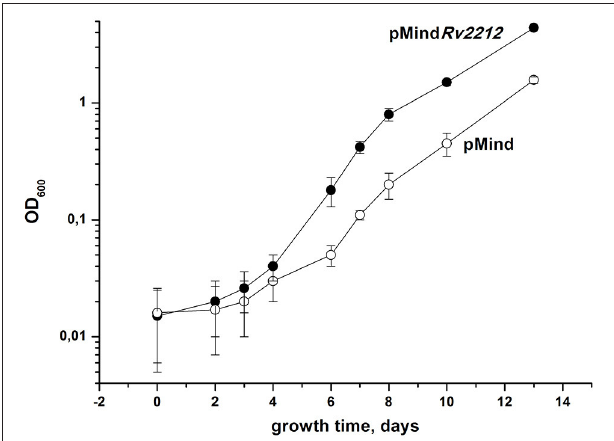
FIGURE 1 | Growth of M. tuberculosis strains in the standard Sauton’s medium. Recombinant M. tuberculosis strains containing pMind Rv2212 vector (closed circles) or empty pMind vector (open circles) were cultured in the standard Sauton’s medium with agitation (200 rpm) at 37 ◦ C. Initial size of inoculum was 10 2 cells per ml. This experiment was repeated three times with similar results. One representative experiment is